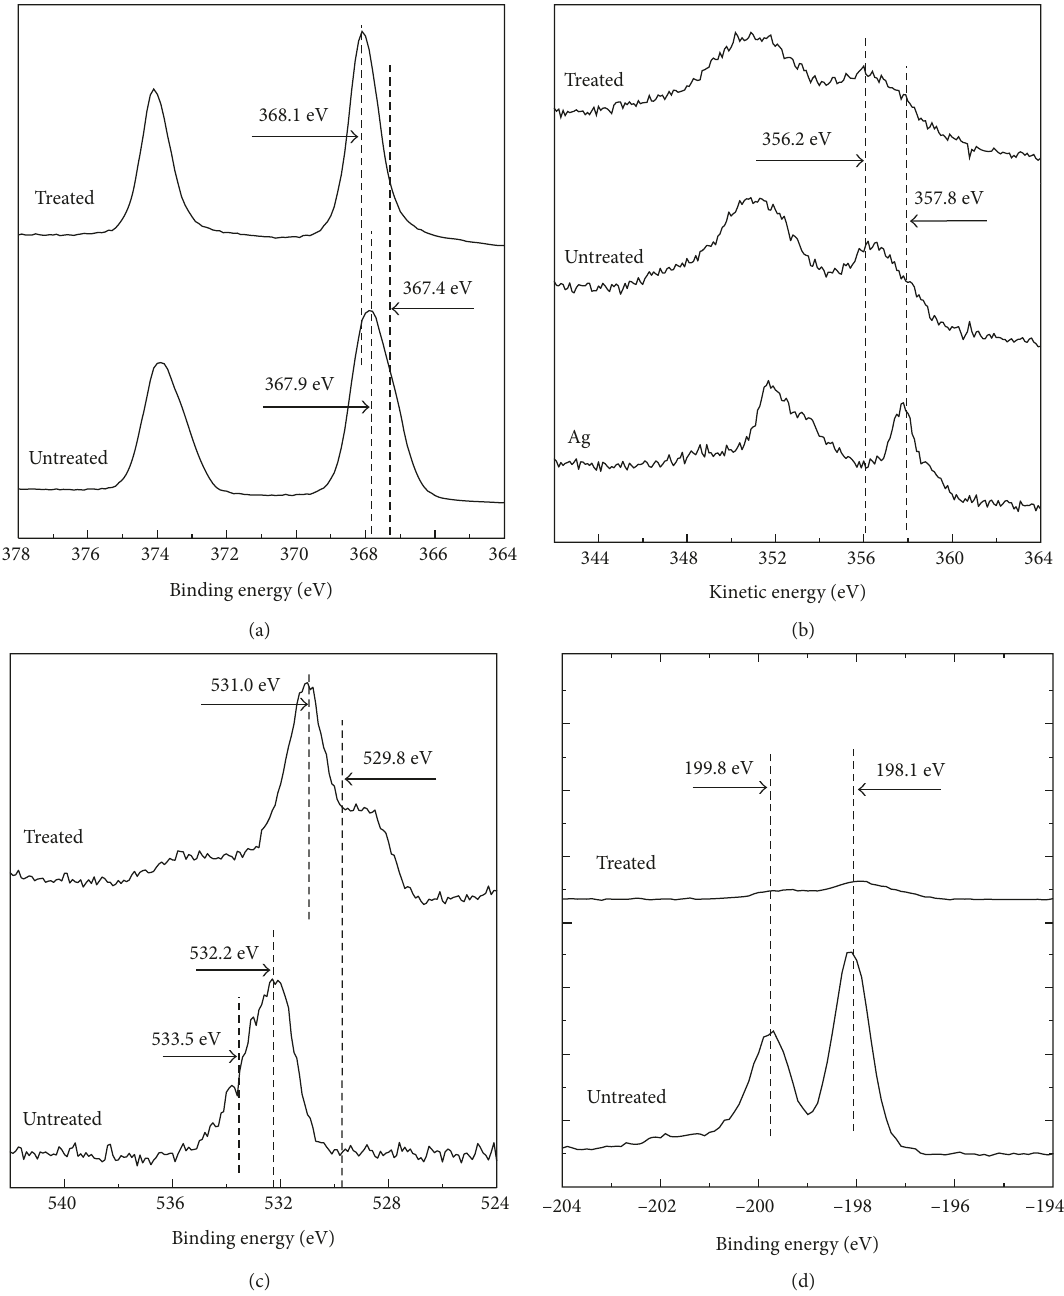
Figure 9: High-resolution surface XPS spectra before and after conditioning in NaOH solution: (a) Ag3d photoelectron lines; (b) AgMNN Auger lines; (c) O1s photoelectron lines; (d) Cl2p photoelectron